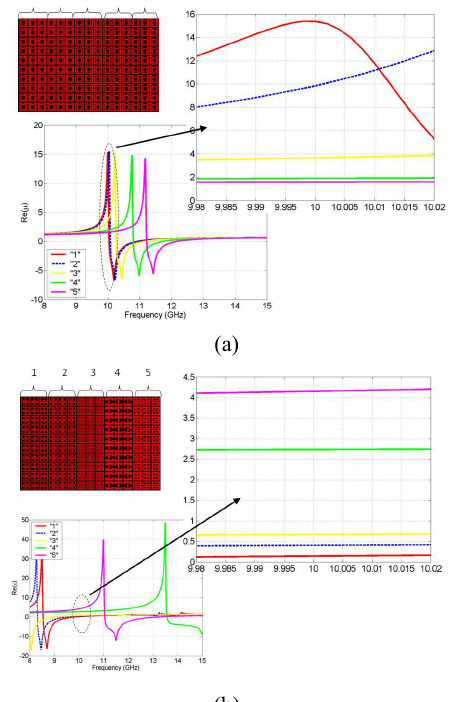
Figure 4: (a) Magnetic response of the SRR for the 5 regions. (b) Electric response of the ELC for the 5 regions.